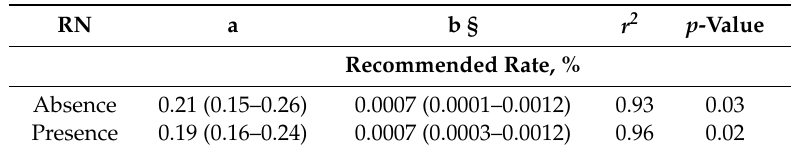
Figure 4. Nitrogen treatment affects the efficiency of photosystem II of cotton under the presence and absence of the reniform nematode. Measurements were taken at 30 days after planting. Data are means ± SE ( n = 32plants in total for fourreplications and two runs). Table 7. Quadratic equation constants, coefficients of determination, and levels of significance for the efficiency of photosystem II of cotton for nitrogen treatment under the presence and absence of reniform nematode (RN) measured at 30 days after planting.